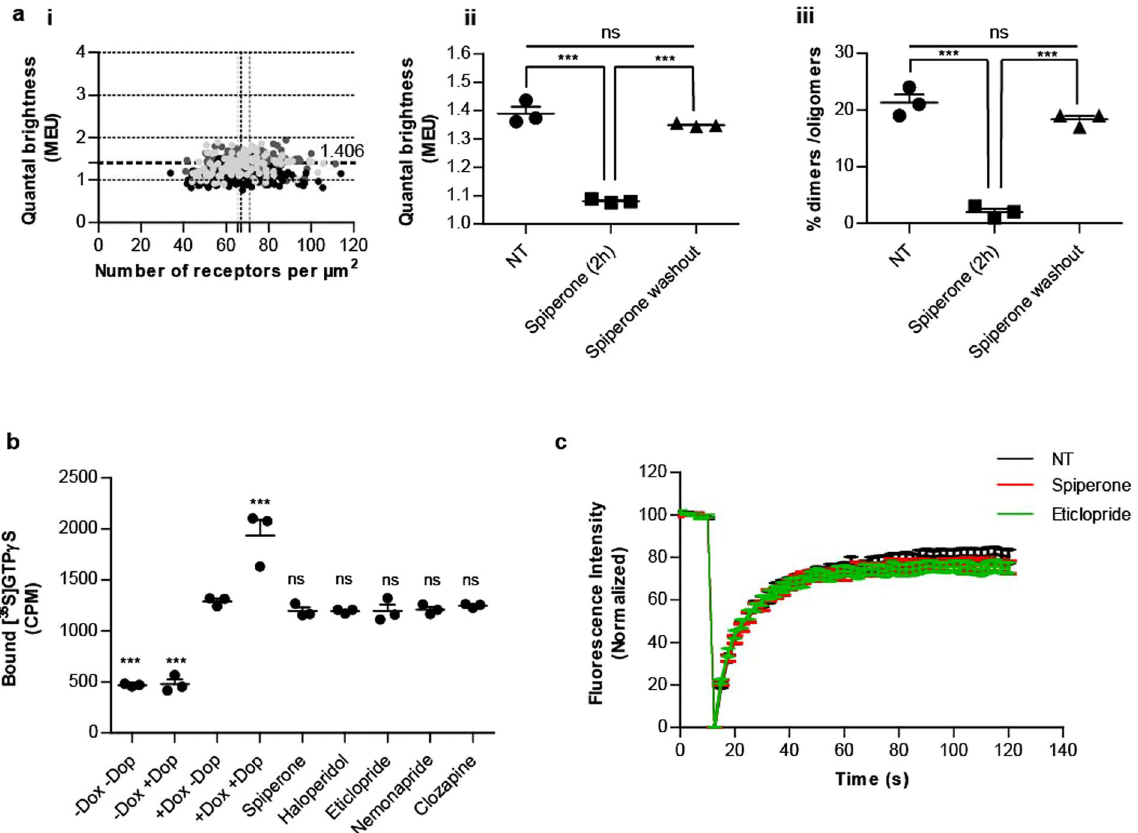
Figure 9. The effect of spiperone on hD 3 R quaternary arrangement is reversible and cannot be attributed to ligand inverse agonism or ligand-induced differences in receptor mobility. ( a ) Flp-In T-REx 293 hD 3 R- mEGFP clone 2 cells were untreated (NT), treated with spiperone for 2 hours (spiperone (2 h)) or treated with spiperone for 2 hours and washed in growth medium at 37 °C for 4 hours (spiperone washout). QB MEU were assessed in individual RoI and plotted against the number of hD 3 R-mEGFP per µ m 2 at the cell surface. Dark grey circles , untreated cells (NT); Black circles , cells treated with spiperone for 2 h ; Light grey circles , cells treated with spiperone for 2 h and washed in growth medium for 4 h ( a ( i )). Quaternary organization of hD 3 R– mEGFP receptor was expressed as QB MEU value and was equal to 1.39 ± 0.02, 1.08 ± 0.01 and 1.35 ± 0.01 in vehicle-, spiperone- and spiperone-treated followed by washout of the ligand cells, respectively ( a ( ii )). RoIs containing predominantly dimers/oligomers corresponded to 21.3 ± 1.5, 2.00 ± 0.6 and 18.3 ± 0.7% in vehicle-, spiperone- and spiperone-treated followed by washout cells, respectively ( a ( iii )). Combined data from n = 3 × 44 experiments (performed in parallel), with the average value from each experiment shown, error bars represent ± S. E.M., *** p < 0.001, when compared to the indicated treatment, ns = not significant. ( b ) Membranes from Flp-In T-REx 293 hD 3 R + Cys 352 Ile G o1 cells maintained in the absence ( − Dox) or presence of 100 ng.ml − 1 doxycycline ( + Dox) were used to measure basal [ 35 S]GTP γ S binding ( − Dop) and the effect of 10 μ M dopamine ( + Dop). Addition of receptor saturating concentrations of spiperone, haloperidol, eticlopride, nemonapride or clozapine did not reduce the basal level of [ 35 S]GTP γ S binding. Combined data from n = 3 experiments, error bars represent ± S. E.M., *** p < 0.001, ns = not significant when compared to basal ( + Dox − Dop). ( c ) Analysis of the recovery of fluorescence intensity after mEGFP photobleaching at the basolateral membrane of Flp-In T-REx 293 hD 3 R-mEGFP clone 2 cells untreated (black) or treated with receptor saturating concentration of spiperone (red) or eticlopride (green). Combined data from n = 11 experiments, error bars represent ±